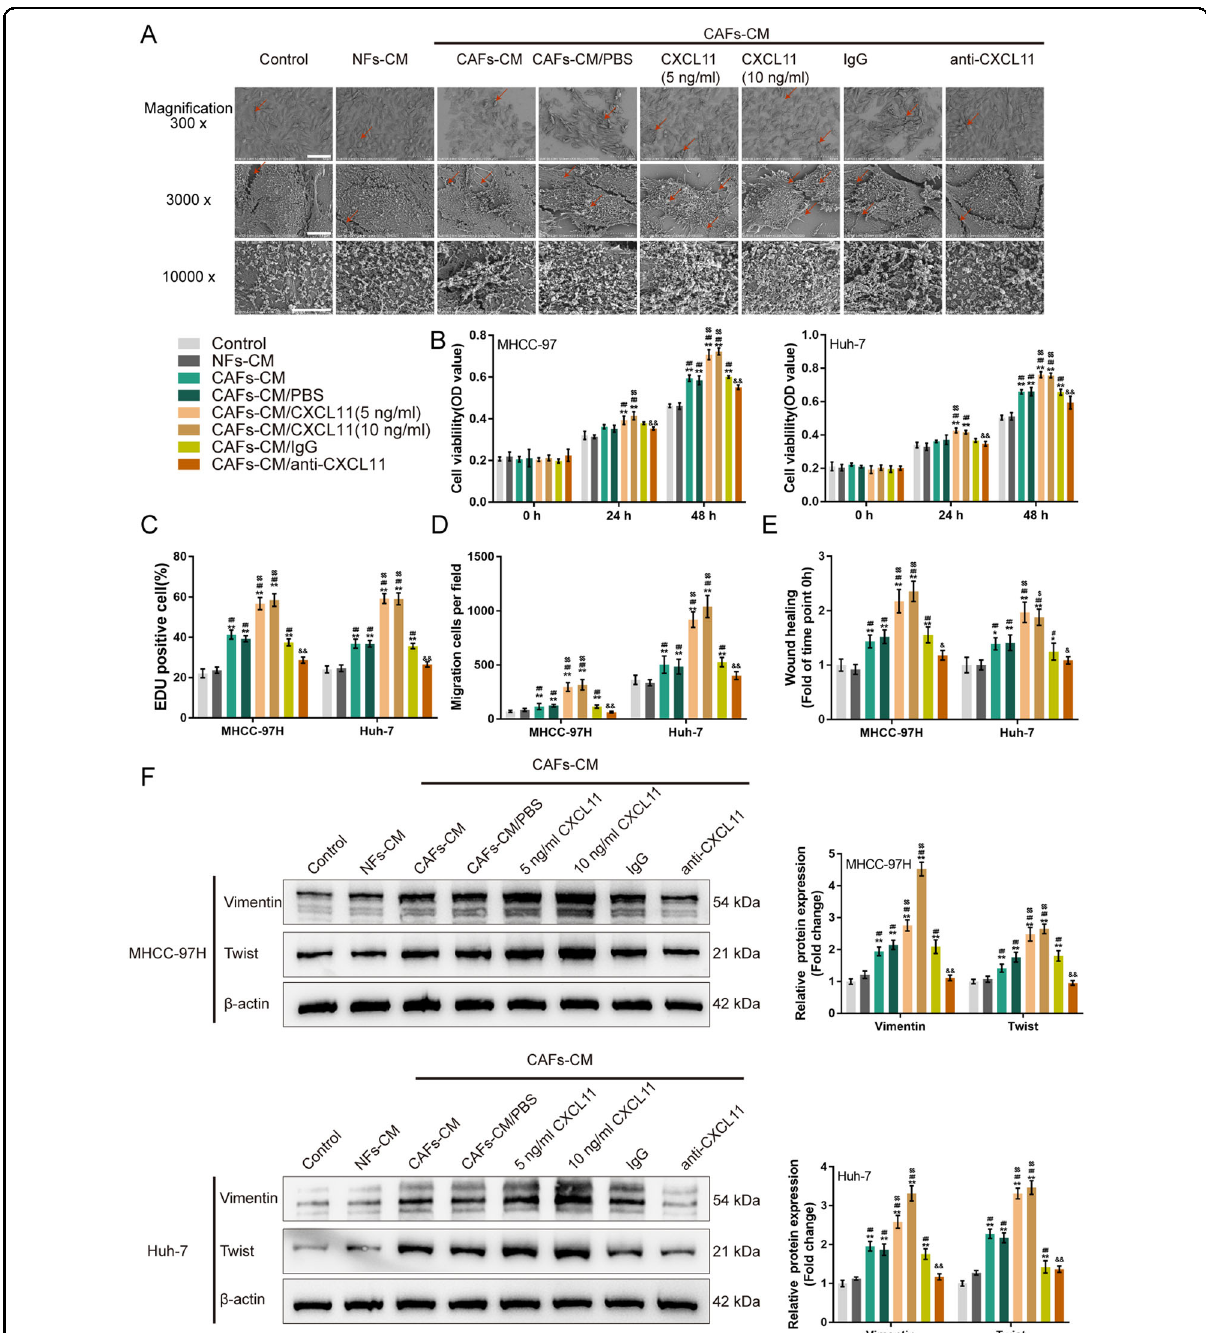
Fig. 2 CAFs-derived CXCL11 affecting hepatocellular carcinoma (HCC) cell phenotype. HCC cell lines, MHCC-97H, and Huh-7, were cultured in control medium (Control), NFs-derived conditioned medium (NFs-CM), CAFs-derived conditioned medium (CAFs-CM), CAFs-CM added with PBS (CAFs-CM/PBS), CAFs-CM added with 5 ng/ml CXCL11 (CAFs-CM/CXCL11 (5 ng/ml)), CAFs-CM added with 10 ng/ml CXCL11 (CAFs-CM/CXCL11 (10 ng/ml)), CAFs-CM added with IgG (CAFs-CM/IgG), and CAFs-CM added with anti-CXCL11 (CAFs-CM/anti-CXCL11). A The morphological changes of HCC cell line MHCC-97H were examined by scanning electron microscopy (SEM) with different magni fi cations; red arrows indicated the pseudopodia of HCC cells. B HCC cells viability was determined by MTT assays. C HCC cell DNA synthesis ability was determined by EDU assay. D HCC cell migration was examined using Transwell assay. E HCC cell migration was examined by wound healing assay. F The protein levels of Vimentin and Twist was examined by Immunoblotting. * P < 0.05, ** P < 0.01, compared with the control group; # P < 0.05, ## P < 0.01, compared with the NFs-CM group; $ P < 0.05, $$ P < 0.01, compared with the CAFs-CM/ P BS group; & P < 0.05, && P < 0.01, compared with the CAFs-CM/IgG